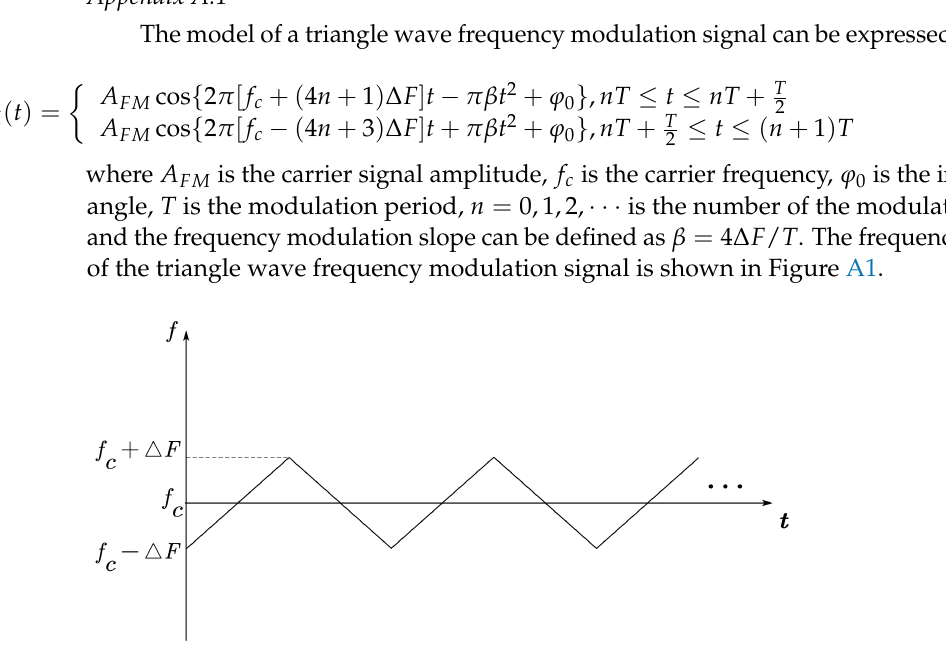
Figure A1. The frequency variation of the triangle wave frequency modulation